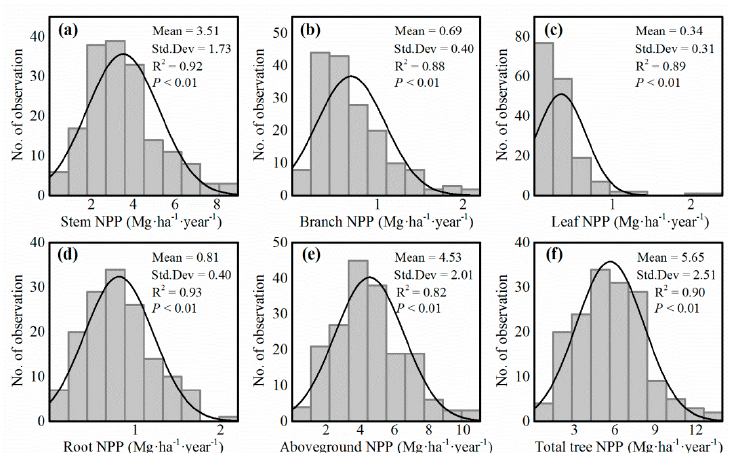
Figure 3. Frequency distributions of ( a ) stem, ( b ) branch, ( c ) leaf, ( d ) root, ( e ) aboveground organs and ( f ) total tree net primary productivity (NPP) of P. massoniana forests in south China. The mean and standard deviation values are presented. The curves were fitted by a Gaussian function.